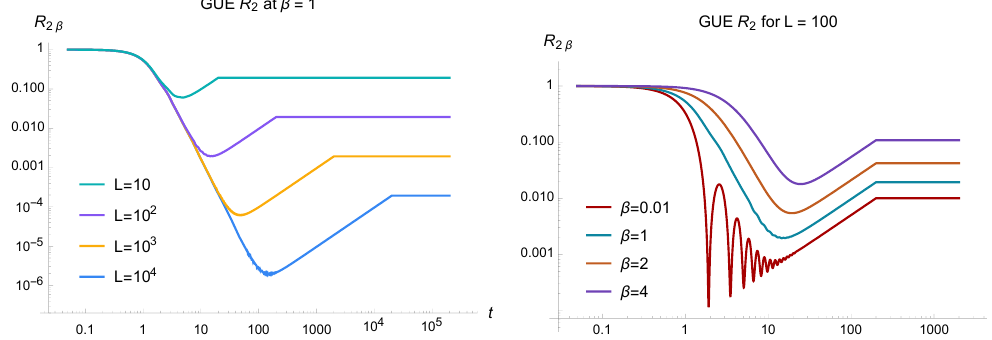
Figure 3 . The 2-point spectral form factor at (cid:12)nite temperature as per eq. (2.28), on the left plotted at di(cid:11)erent values of L , and on the right plotted at di(cid:11)erent temperatures, normalized by the initial value. We see that the dip and plateau both scale with (cid:12) and L and that lowering the temperature smooths out the oscillations in R 2